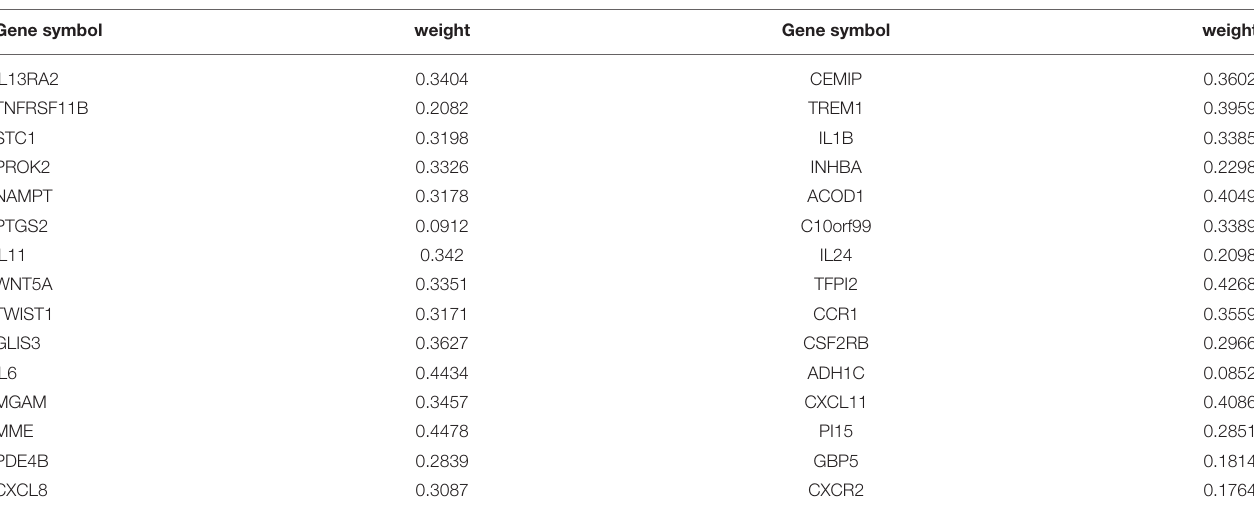
TABLE 2 | The “Gene Weight” of top 30 DEGs in the training dataset. Gene